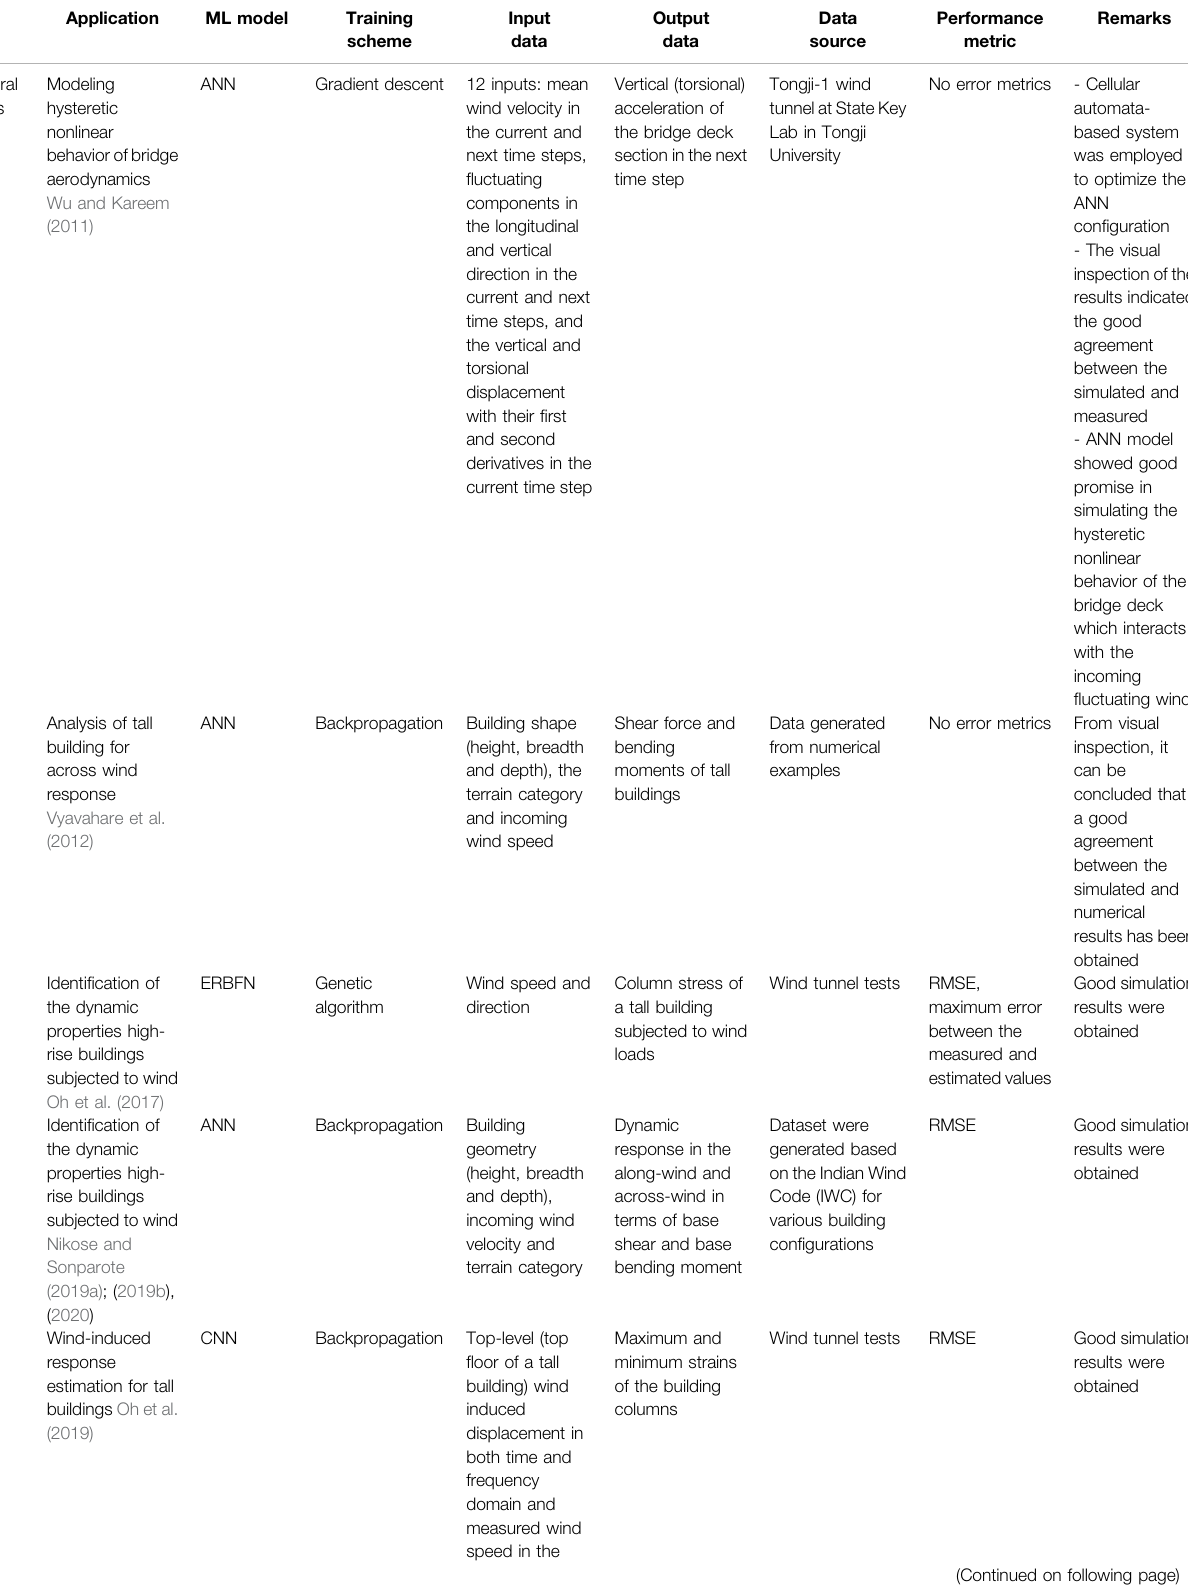
TABLE 6 | Summary of ML applications for structural dynamics and damage